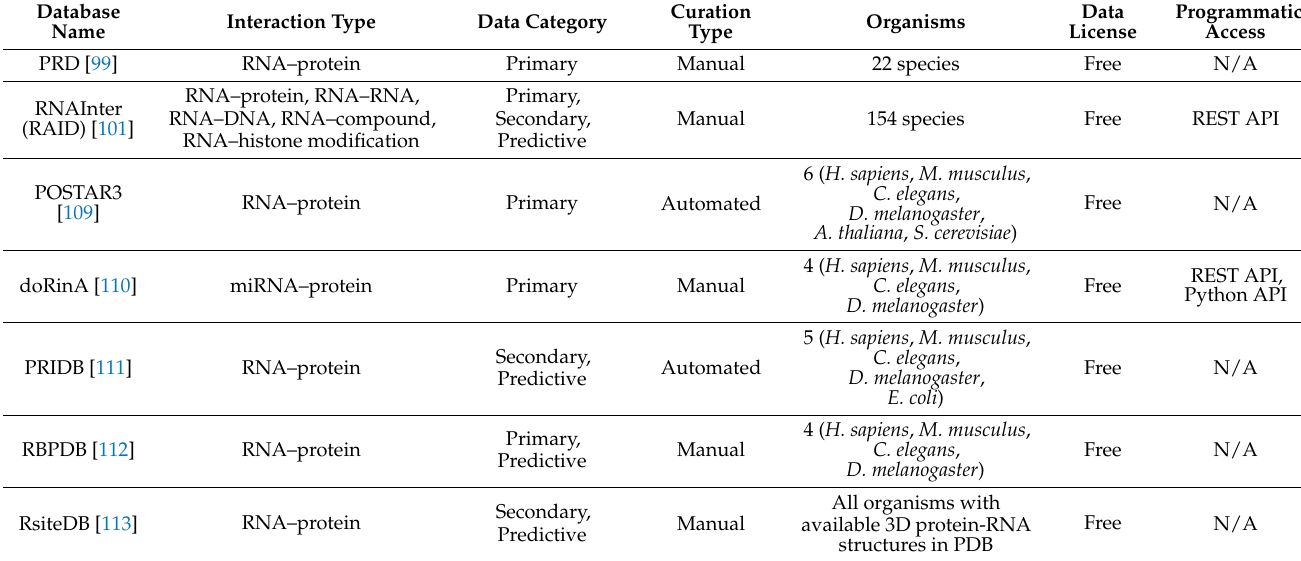
Table 3. RNA–Protein interactions